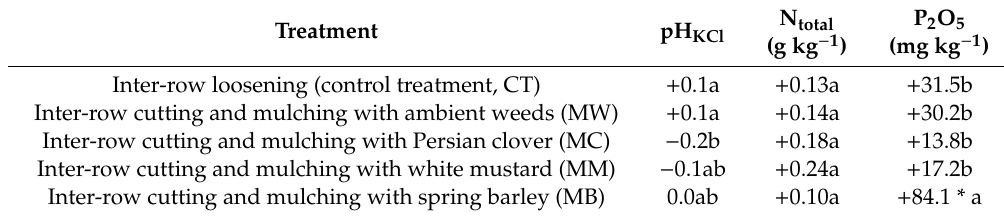
Table 3. The e ff ect of intercropping on the change of pH, nitrogen and phosphorus in the soil, 2015–2017. N total P 2 O 5 Treatment pH KCl (g kg − 1 ) (mg kg − 1 ) Inter-row loosening (control treatment, CT) + 0.1a + 0.13a + 31.5b Inter-row cutting and mulching with ambient weeds (MW) + 0.1a + 0.14a + 30.2b Inter-row cutting and mulching with Persian clover (MC) − 0.2b + 0.18a + 13.8b Inter-row cutting and mulching with white mustard (MM) − 0.1ab + 0.24a + 17.2b Inter-row cutting and mulching with spring barley (MB) 0.0ab + 0.10a